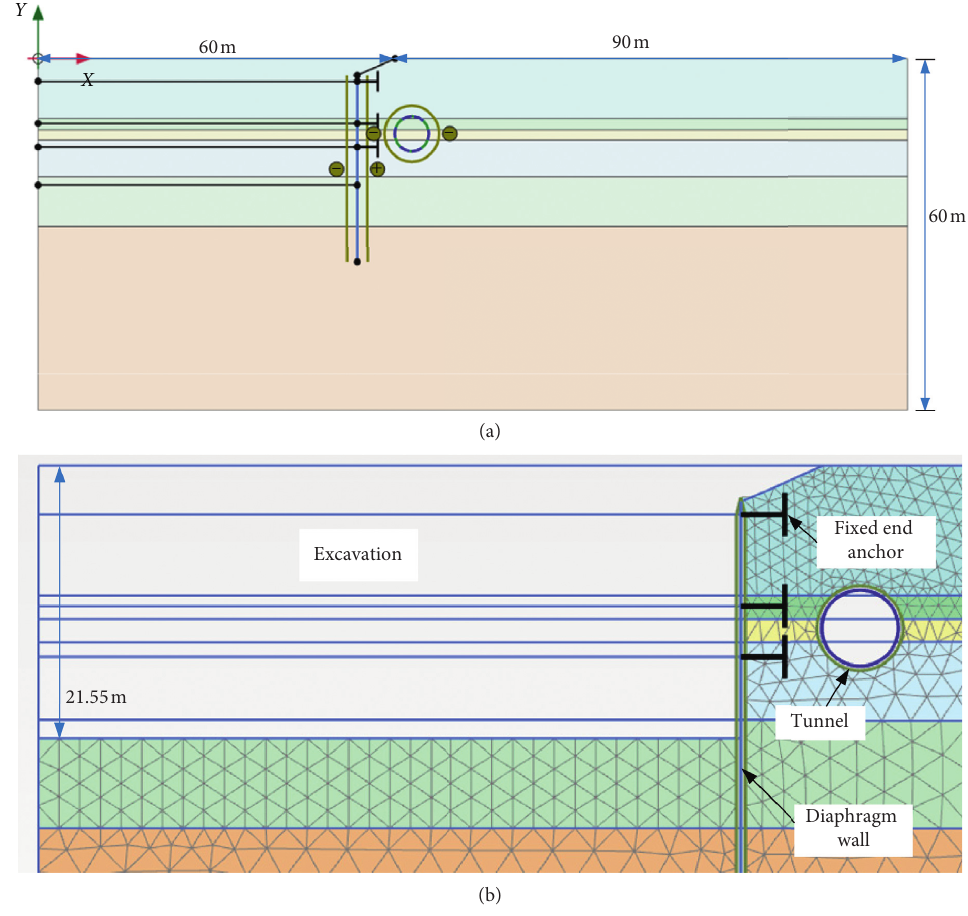
Figure 24: Finite element mesh of the simulation